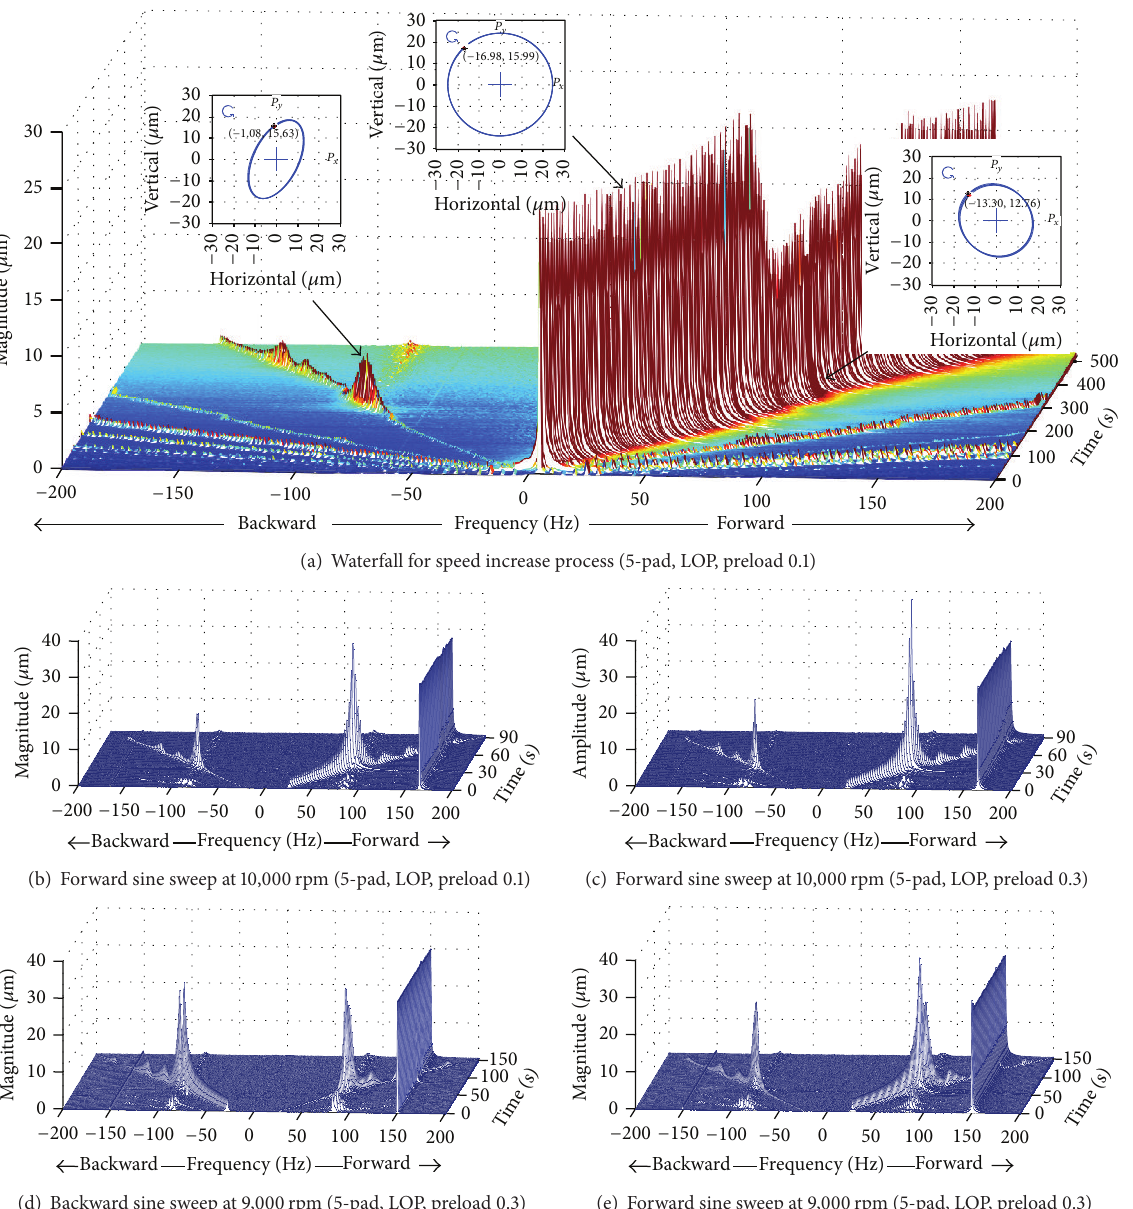
Figure 5: Waterfall plot of the test